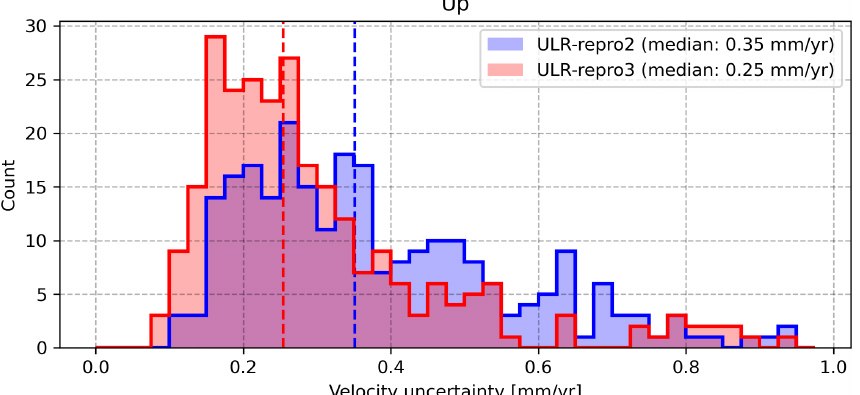
Figure 8. Vertical velocity uncertainties for ULR-repro3 with respect to the previous ULR solution based on the 251 common stations. The vertical dashed lines correspond to the